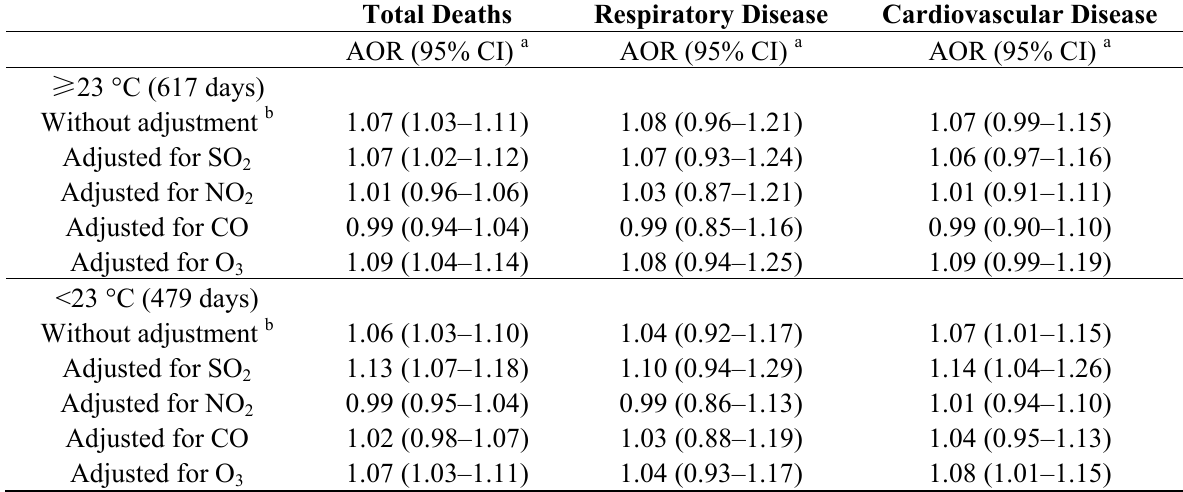
Table 4. Adjusted odds ratios (AORs) and 95% confidence intervals (CIs) for daily mortality for each interquartile range increase of PM stratified by